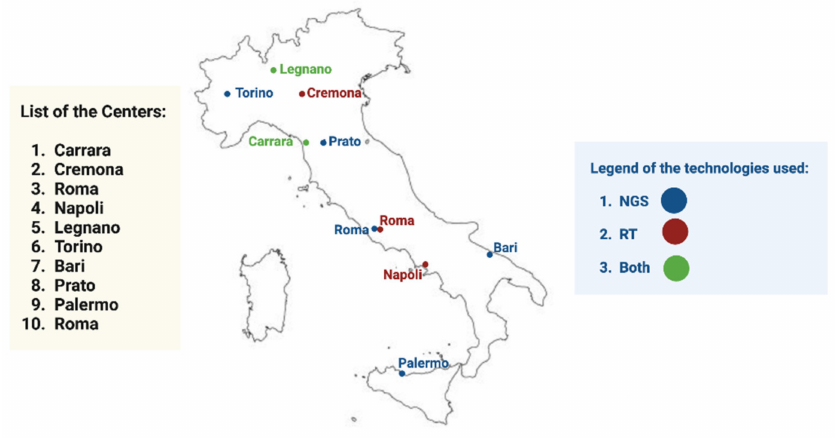
Figure 1. List of participating centers in this study. The techniques used in each center are color